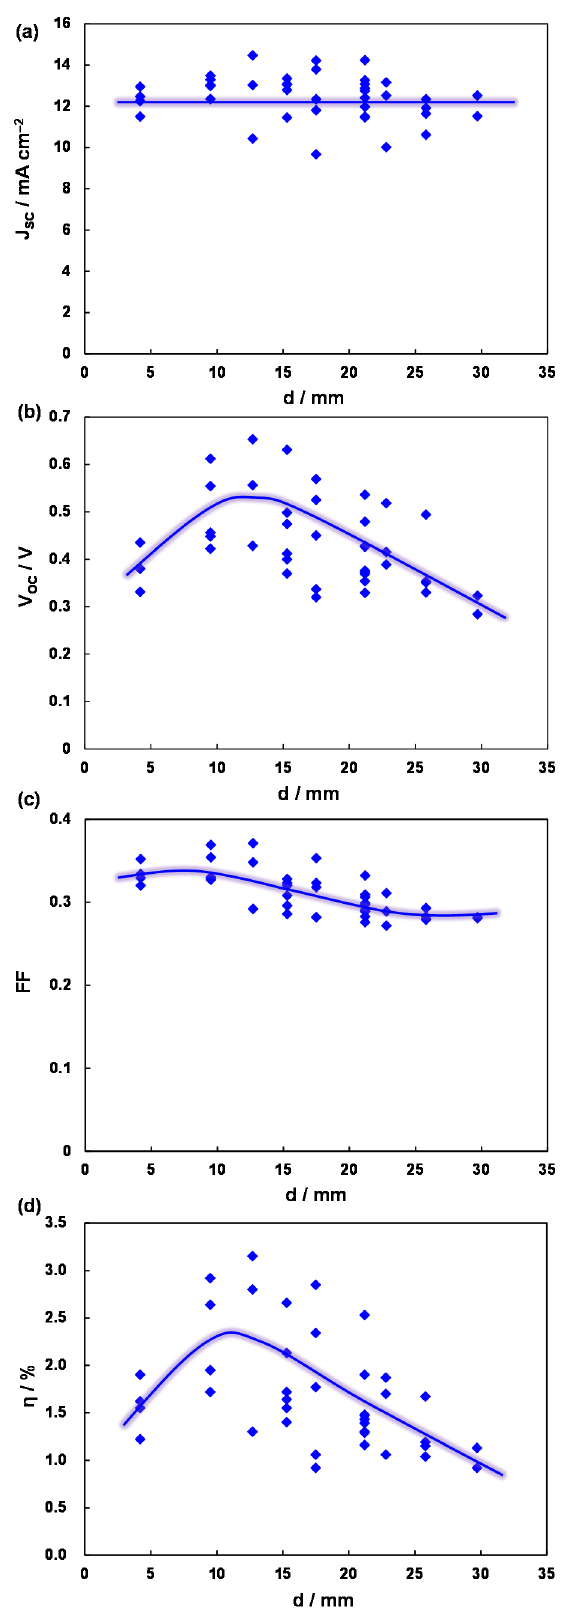
Figure 4. Measured ( a ) short-circuit current density; ( b ) open-circuit voltage; ( c ) fill factor and ( d ) conversion efficiency of TiO 2 /CH 3 NH 3 PbI 3 cell as a function of the distance from the center of the